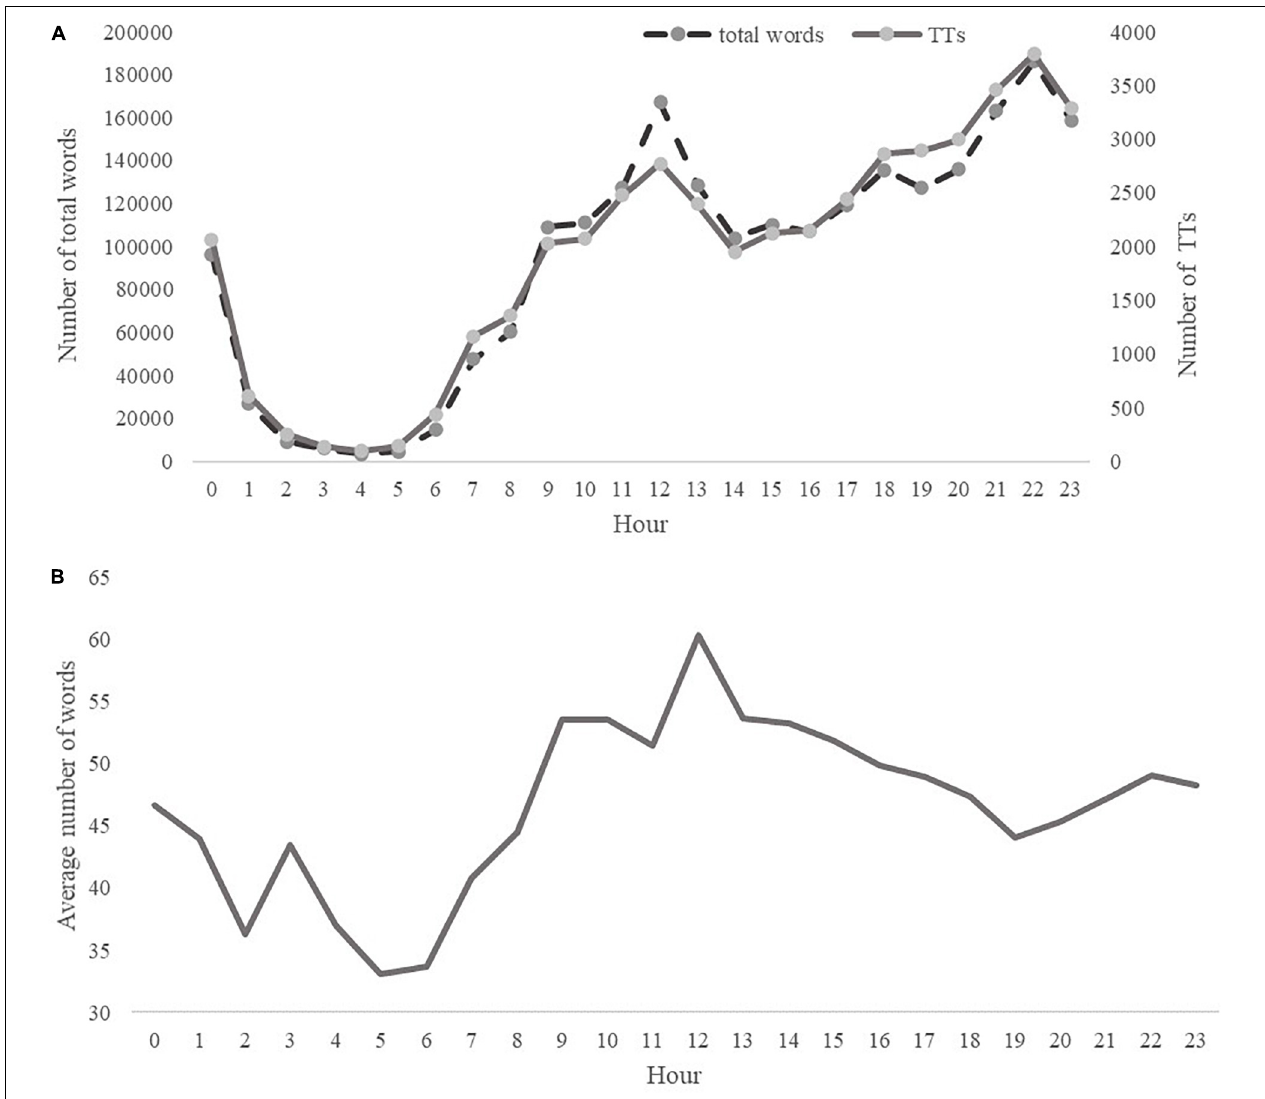
FIGURE 1 | (A) Daily rhythms of the number of total words and TTs. (B) Daily rhythms of the average number of words per